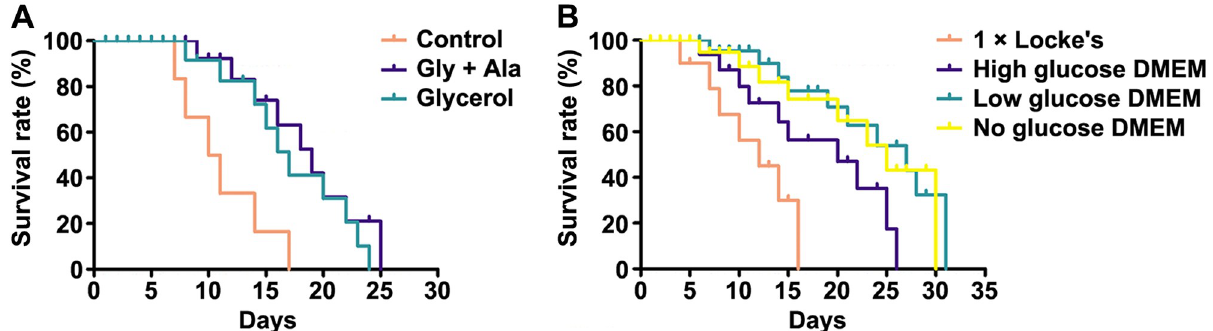
Fig 1. Survival curve of C . sinensis adults maintained on inorganic solutions and nutrient media. (A) Survival curve of adult flukes maintained on 1 × Locke’s (control), 1 × Locke’s containing 0.25% Gly and 0.25% Ala (Gly + Ala), as well as 1 × Locke’s containing 0.5% glycerol (glycerol). (B) Survival curve of adult flukes maintained on 1 × Locke’s and different DMEM. Survival curve was constructed using Kaplan-Meier analysis with the log-rank test.